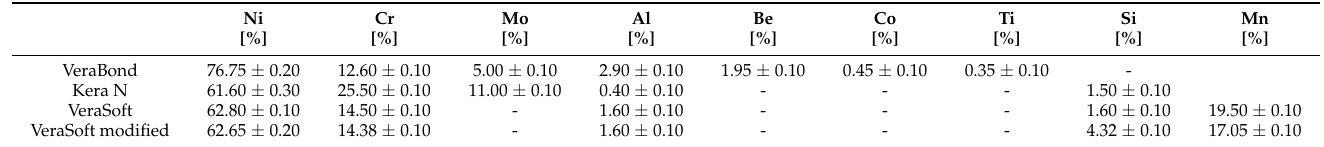
Table 1. The chemical composition of the alloys